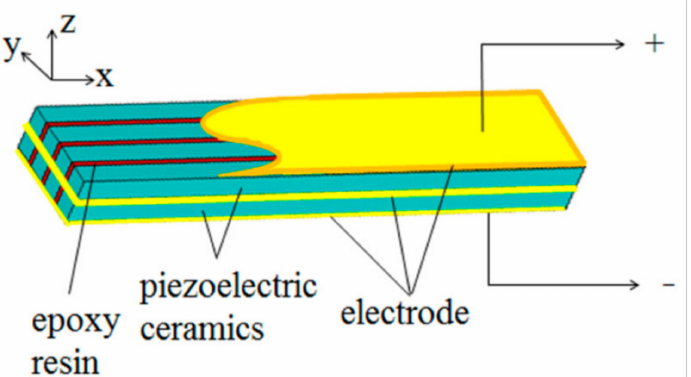
Figure 11. Structure of the piezoelectric composite bi-laminated vibrator [82].